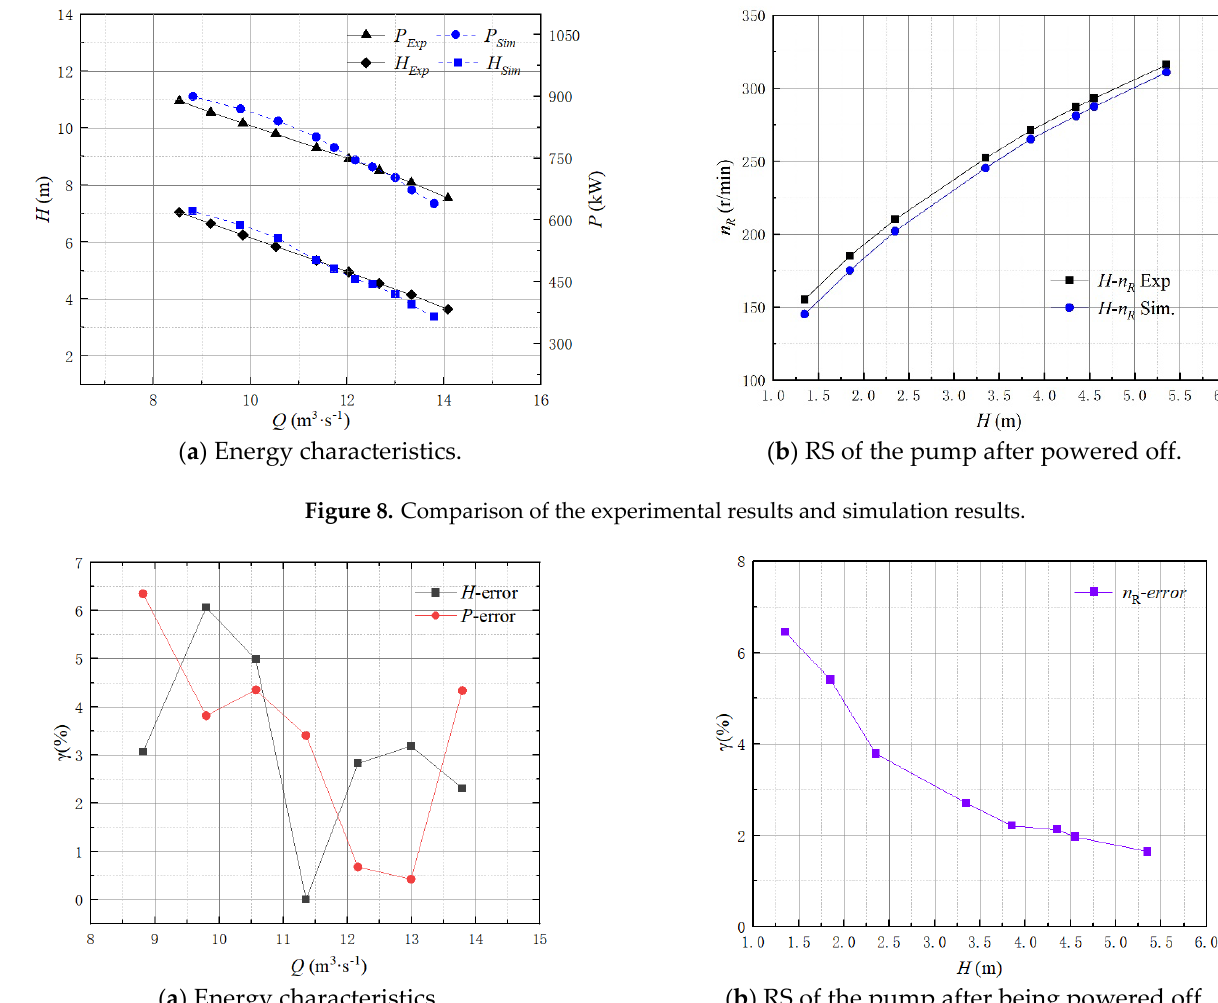
Figure 9. Error analysis of the numerical simulation.